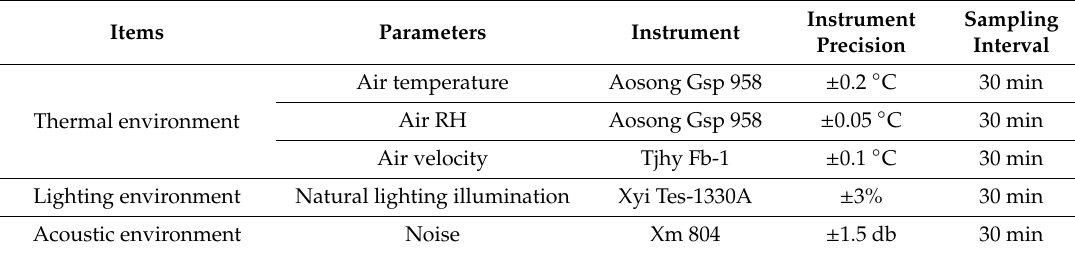
Table 3. Measurement parameters and instruments used to determine environmental quality.